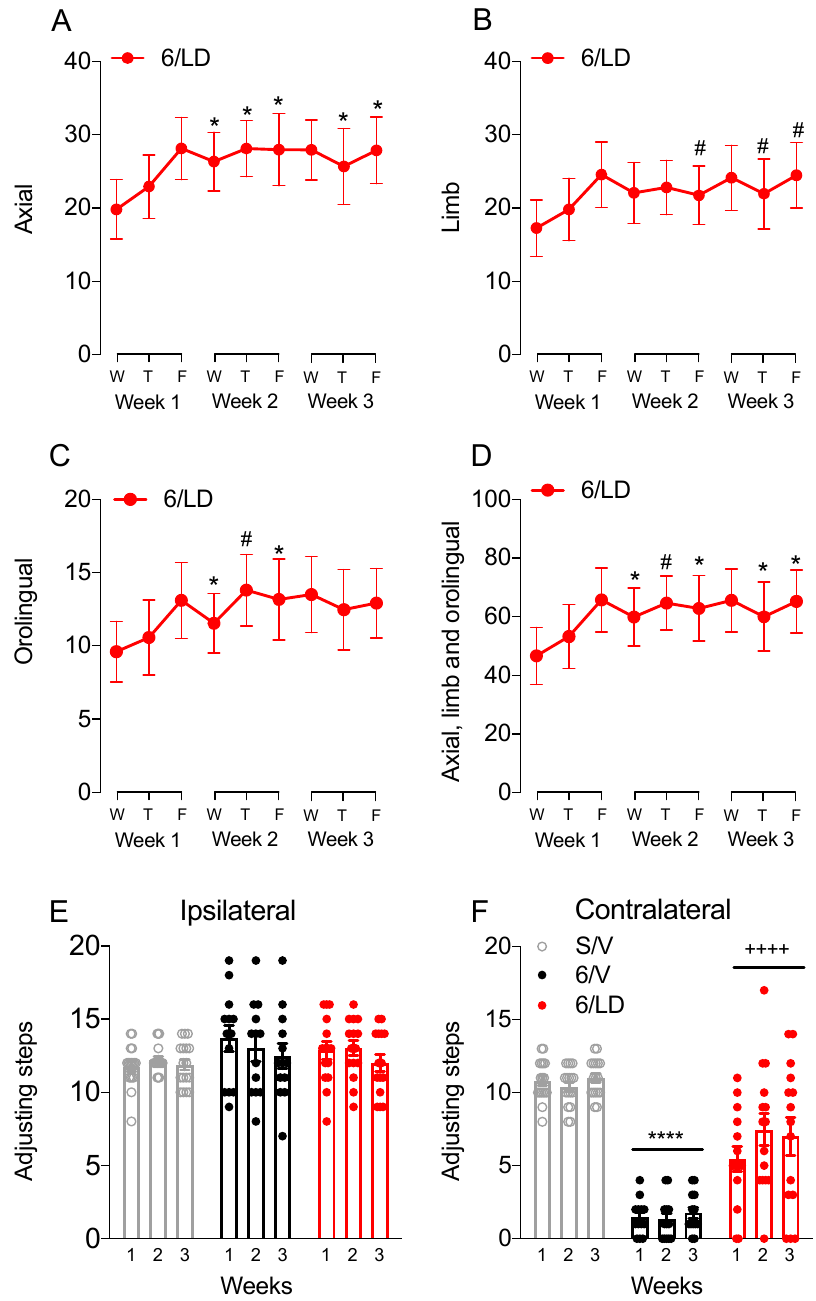
Figure 2. Effects of chronic L-DOPA administration on AIMs and stepping test. The temporal profile of ( A ) axial, ( B ) limb, ( C ) orolingual, and ( D ) sum of axial, limb, and orolingual AIMs is detailed for each week of chronic L-DOPA treatment. The analysis revealed that L-DOPA increased the incidence of AIMs throughout chronic administration ( # p < 0.10, * p < 0.05 vs. Wednesday on Week 1, one-way RM-ANOVA and Holm-Sidak post-hoc test). L-DOPA had no effect on the stepping test performed with the ( E ) ipsilateral forelimb and partially improved stepping test performance with the ( F ) contralateral forelimb (**** p < 0.001 vs. S/V group, ++++ p < 0.001 vs. 6/V group). Data expressed as mean ± SEM. Results are derived from n=17 animals in the S/V group, n = 13 in the 6/V group, and 15 in the 6/ LD group. Abbreviations: W = Wednesday, T = Thursday, F =